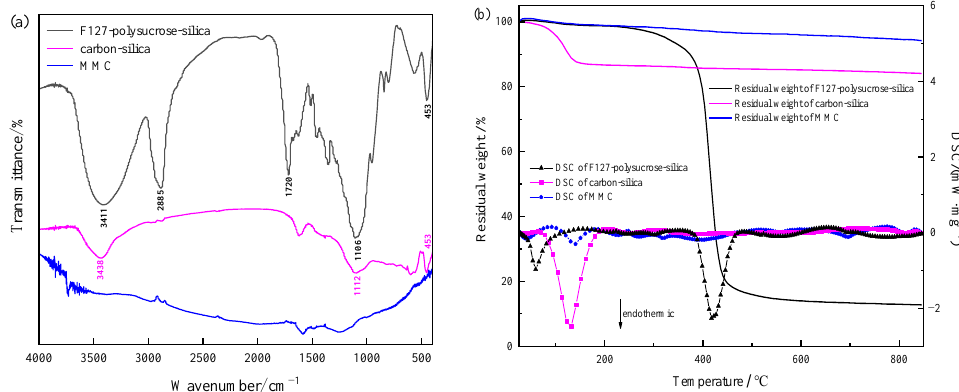
Figure 1. FTIR spectrum ( a ) and TG-DSC curves ( b ) of F127-polysucrose-silica, carbon-silica, and MMC.